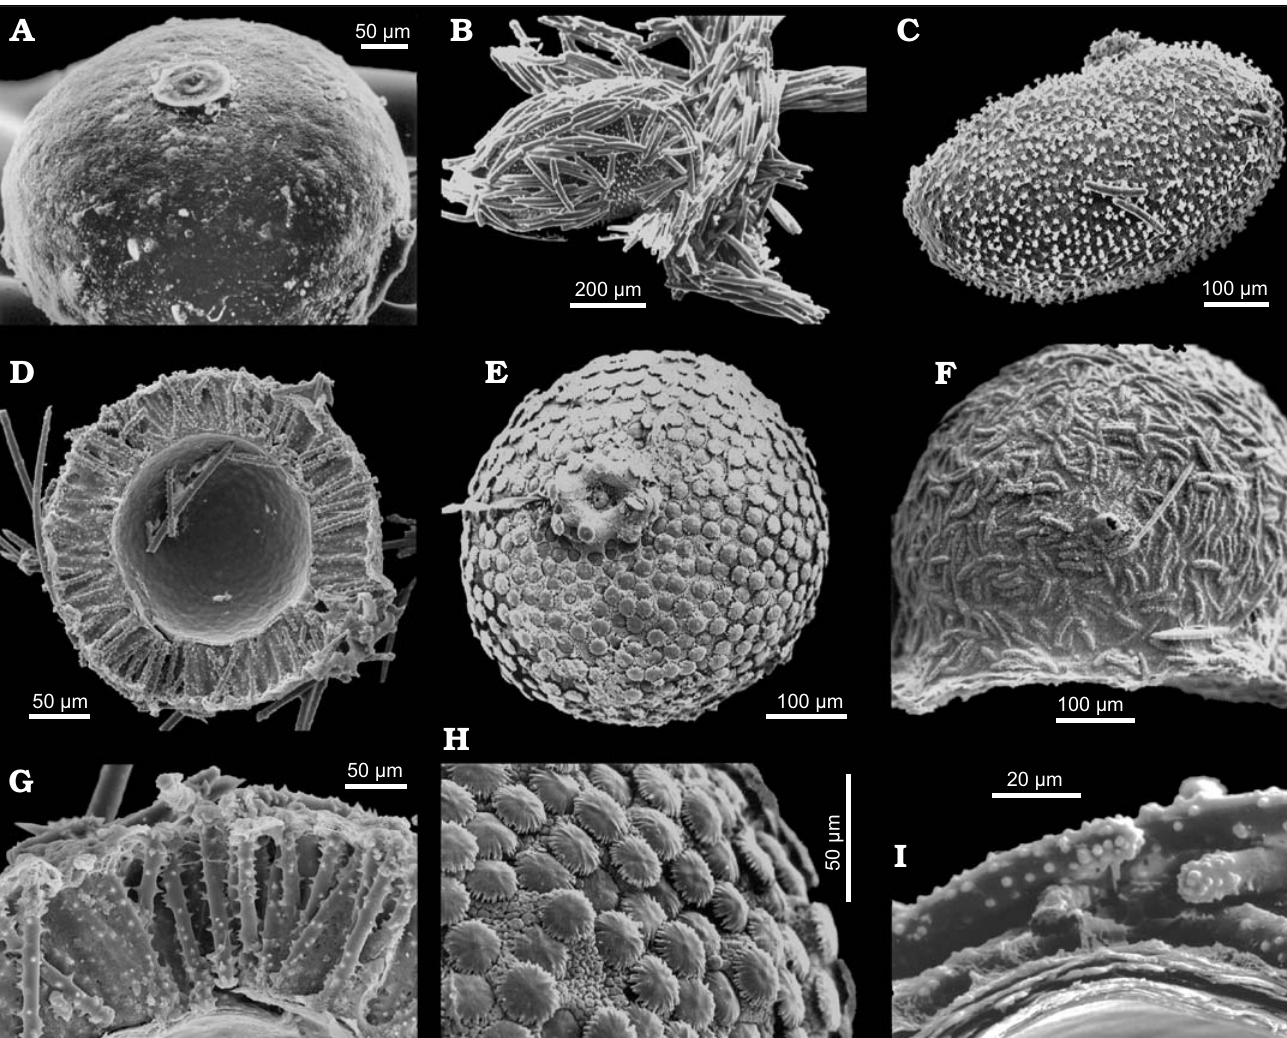
Fig. 4. Gemmule morphology (resting bodies) of Recent freshwater sponges of the order Spongillida. A . Spongilla lacustris (Linnaeus, 1759), Palae- arctic-Nearctic Region, subspherical unarmed gemmular theca. B . Metania reticulata (Bowerbank, 1863), Neotropical Region, cage of tangential megas- cleres around the gemmule. C . M. reticulata , ovoid gemmule (removed from the cage, see B) with radial birotules in the gemmular theca. D . Radiospongilla crateriformis (Potts, 1882), Cosmopolitan, gemmuloscleres radially arranged in the theca (cross section). E . Umborotula bogorensis (Weber, 1890), Palaearctic-Oriental-Australasian Region, subspherical gemmule with distal rotules of gemmuloscleres at the theca surface. F . Stratospongilla bombay- ensis (Carter, 1882), Oriental-Afrotropical Region, hemispherical gemmule with tangential gemmulosclere at the surface. G . R. crateriformis , gemmular theca with radial gemmuloscleres (close up, cross section). H . U. bogorensis , gemmule surface with distal rotules of birotule gemmuloscleres (close up). I . Oncosclera rousseleti (Kirkpatrick, 1906), Afrotropical Region, gemmule surface with tangential strongyle gemmuloscleres (close up, cross section). SEM images. Modified from Manconi and Pronzato (2002, 2005,